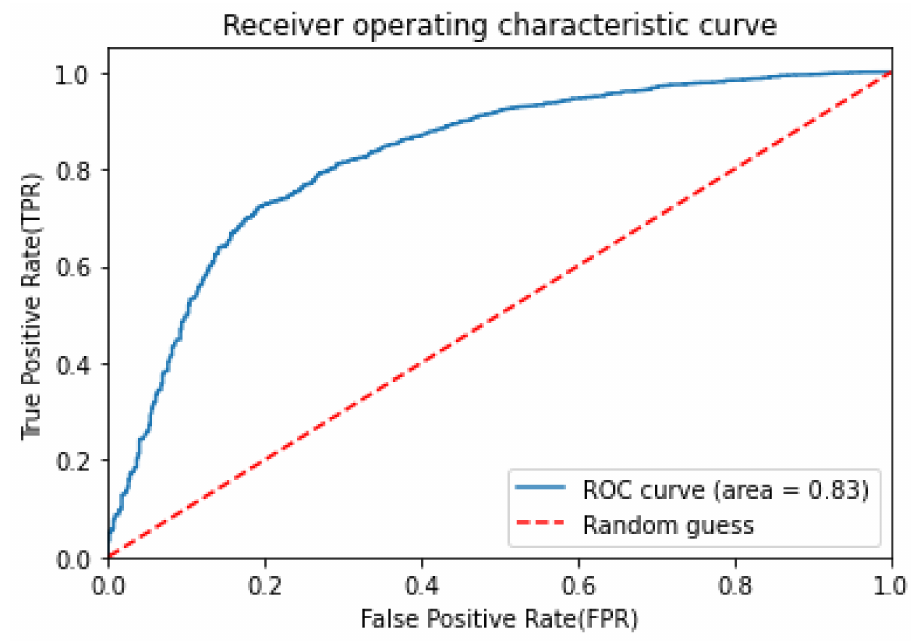
Figure 3. ROC curve of logistic regression. The red line (TPR = FPR) corresponds to the “random guess” model, and the point on the upper left of the red line (TPR > FPR) indicates that the judgment is generally